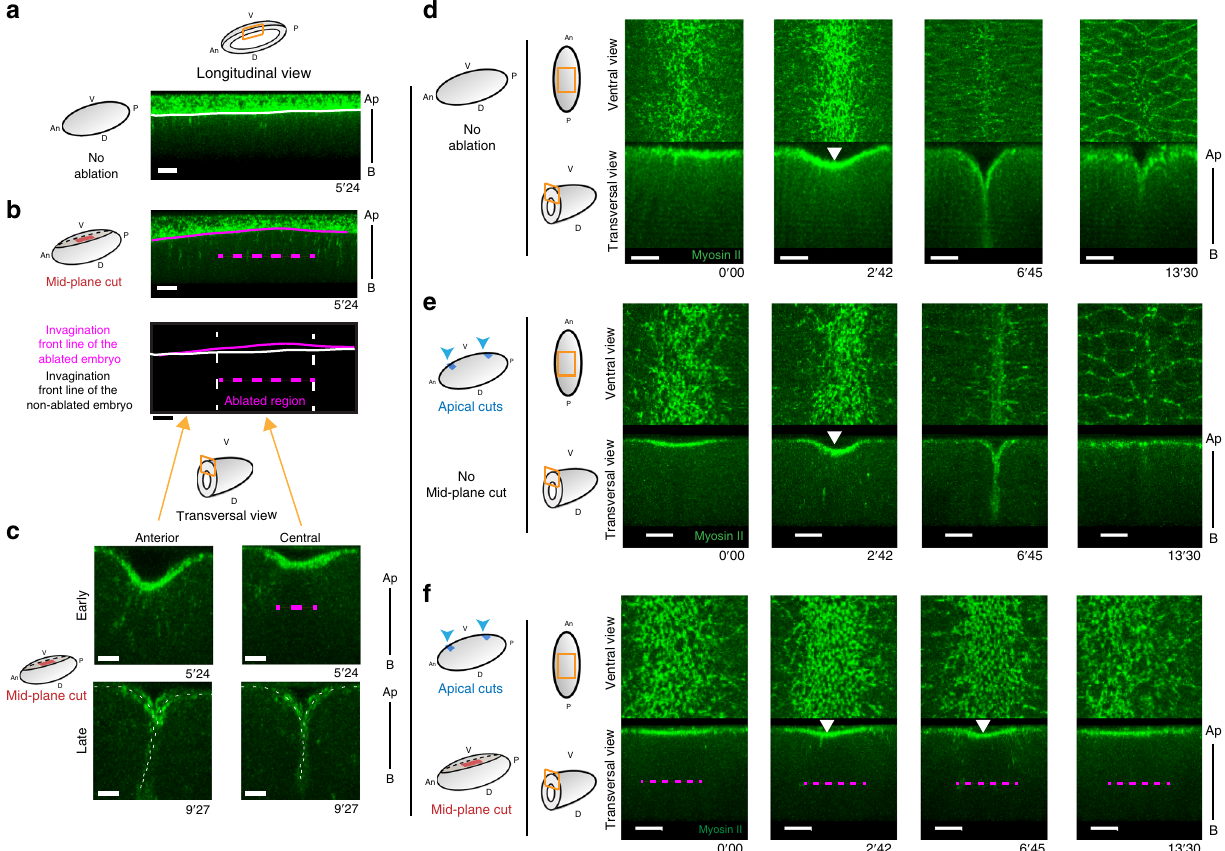
Fig. 6 An apico-basal force drives mesoderm invagination. Schemes recapitulate the orientation of the embryos and the laser cuts performed in each experiment. a Longitudinal views of sqhKI[eGFP] control embryos ( n = 17), showing the linear shape of the invagination front at early stage. b (top) Longitudinal views of sqhKI[eGFP] embryo ablated in the mid-plane region (red rectangle in the scheme and a dashed magenta line in the fi gure, n = 12), showing a slight delay in the central region compared to the anterior one, as shown by the outline of the invagination front in magenta at early stage of invagination. (bottom) Scheme of the invagination fronts in the control (white line, as in a ) and ablated embryo (magenta line). c Anterior (left) and central (right) transversal views of a mid-plane ablated embryo, at two different times of the invagination. Note that invagination proceeds normally as shown by the V-shaped invagination outlined by a white dotted line (bottom), although a delay in the central region can be observed at early stage (top, compare anterior to central region). d Ventral and transversal views extracted from a movie of a control sqhKI[eGFP] embryos, showing the different step of mesoderm invagination. e The apical surface was cut on the anterior and the posterior sides (blue arrowheads, see left schemes) to isolate the central domain of the mesoderm. Note that the invagination is taking place normally, in term of invagination shape, depth and timing ( n = 10). f After isolation of the central domain (apical cuts as described in e ), ablation was performed in the mid-plane of the central region of the mesoderm (red rectangle on the scheme, magenta dashed line in the fi gure). Note that the invagination is totally prevented when apico-basal forces are impaired in the vast majority of the cases ( n = 11/12). e , f Note that apical constriction occurs in both cases, as shown by the curved shape adopted by the ventral surface (white arrowheads). Apico-basal cables are not visible due to low resolution. Scale bar: 10 µ m. An anterior, P posterior, V ventral, D dorsal, Ap apical, B basal. See